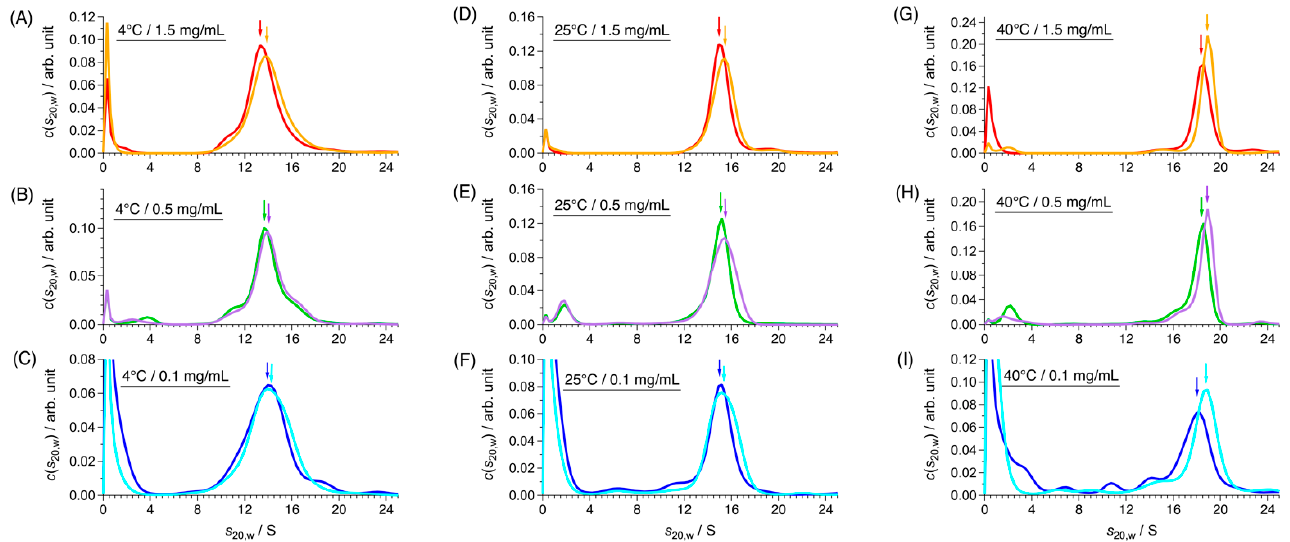
Figure 3. SV-AUC results of CgHspB1 WT and CgHspB1 S15D at ( A – C ) 4 °C, ( D – F ) 25 °C, and ( G – I ) 40 °C. Red, green, and blue lines represent c ( s 20,w ) of CgHspB1 WT at 1.5 mg/mL, 0.5 mg/mL, and 0.1 mg/mL, respectively. Yellow, purple, and cyan lines represent c ( s 20,w ) of CgHspB1 S15D at 1.5 mg/mL, 0.5 mg/mL, and 0.1 mg/mL, respectively. Colored arrows corresponding to the data with the same colors show the main peak positions in c ( s 20,w ) and their parameters are listed in Table 2. Table 2. Parameters of main peak of c ( s 20,w ) in Figure 3.